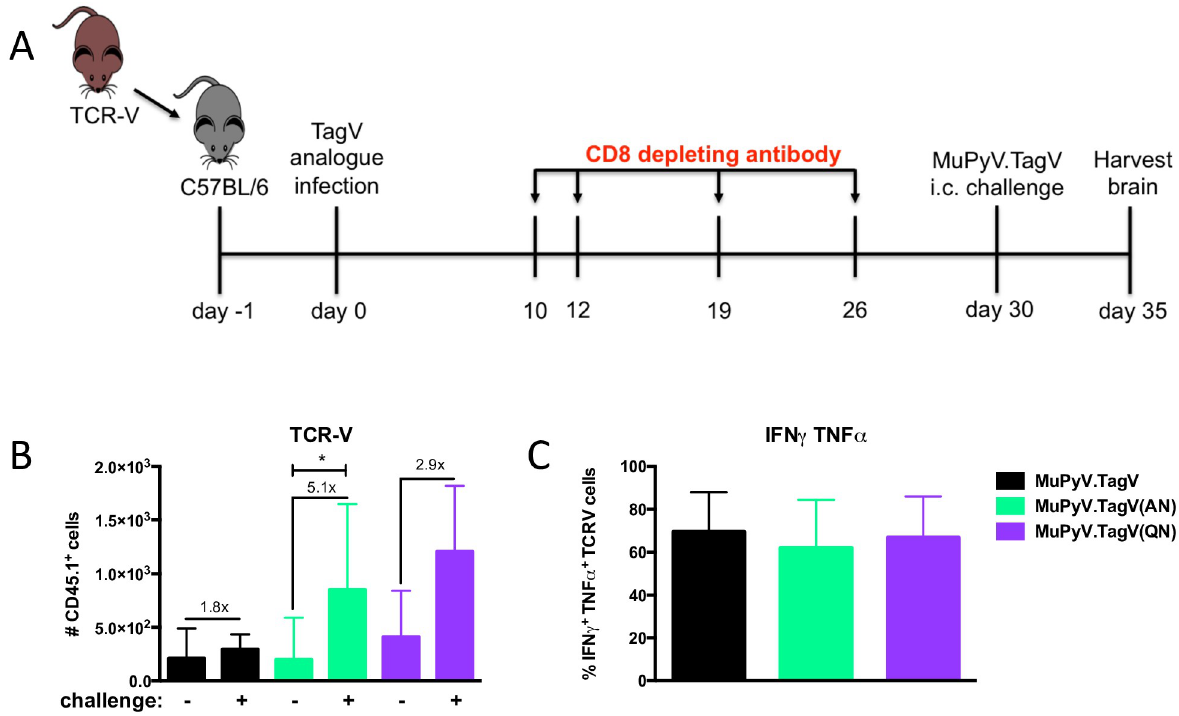
Fig 6. Brain-T RM cells primed with lower stimulation exhibit increased recall potential. (A) 1 x 10 3 donor TCR-V CD8 T cells were adoptively transferred into recipient C57BL/6 mice. Mice were infected with 2 x 10 6 PFU of MuPyV via hind footpads the followingday and given depleting anti-CD8 α on day 10 p.i. and once/weekfor 3 weeks. Mice were challenged i.c. with MuPyV.TagV virus on day 30 p.i. and sacrificedfive days post-challenge. (B) Number of TCR-V cells in the brain with or without secondary challenge (left panel)and fold change of TCR-V cells in mice receivingsecondarychallengecomparedto day 30 averages(right panel). (C) IFN γ and TNF α co- expressionfrom TCR-V cells stimulatedfor 5 h ex vivo with 1 μ M TagV peptide. Mean ± SD plotted. N = 6–15mice from 2–5 independent experiments. * , p < 0.05; ANOVA with Tukey’s test for